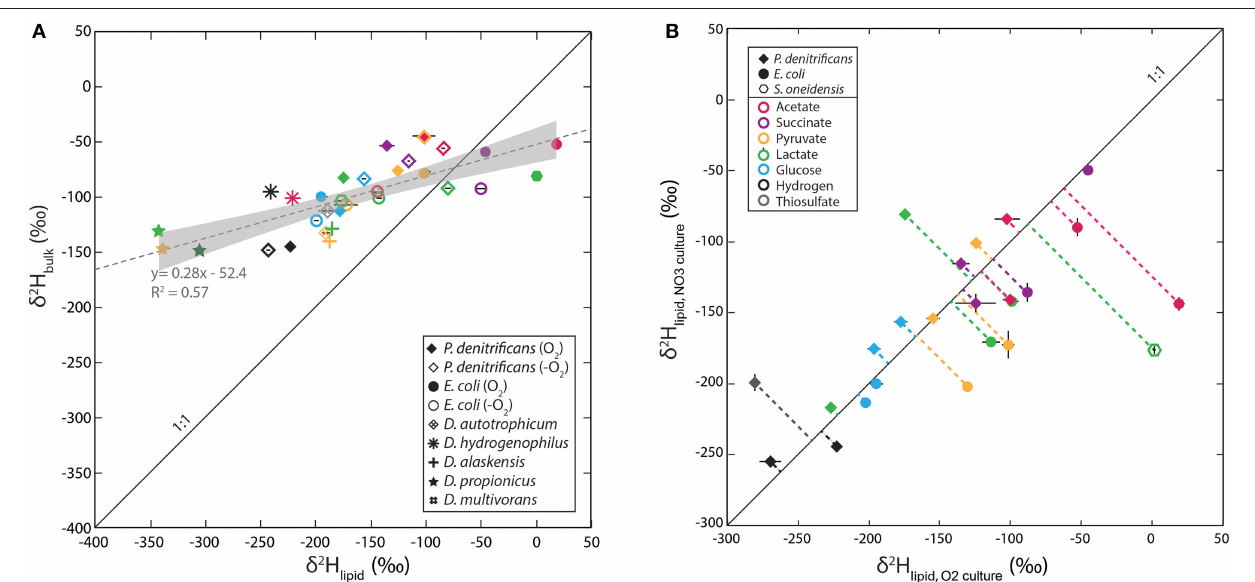
FIGURE 2 | (A) Cross-plot of lipid vs. bulk cellular δ 2 H-values. The dotted gray line in (A) is a linear regression of the data and gray shaded envelope shows 95% confidence intervals on the regression. (B) Cross-plot of δ 2 H-values for aerobic and anaerobic culture conditions for facultative anaerobes. Symbols reflect strains type and color reflects substrate in both graphs. Solid diagonal lines are slopes of 1:1 plotted for